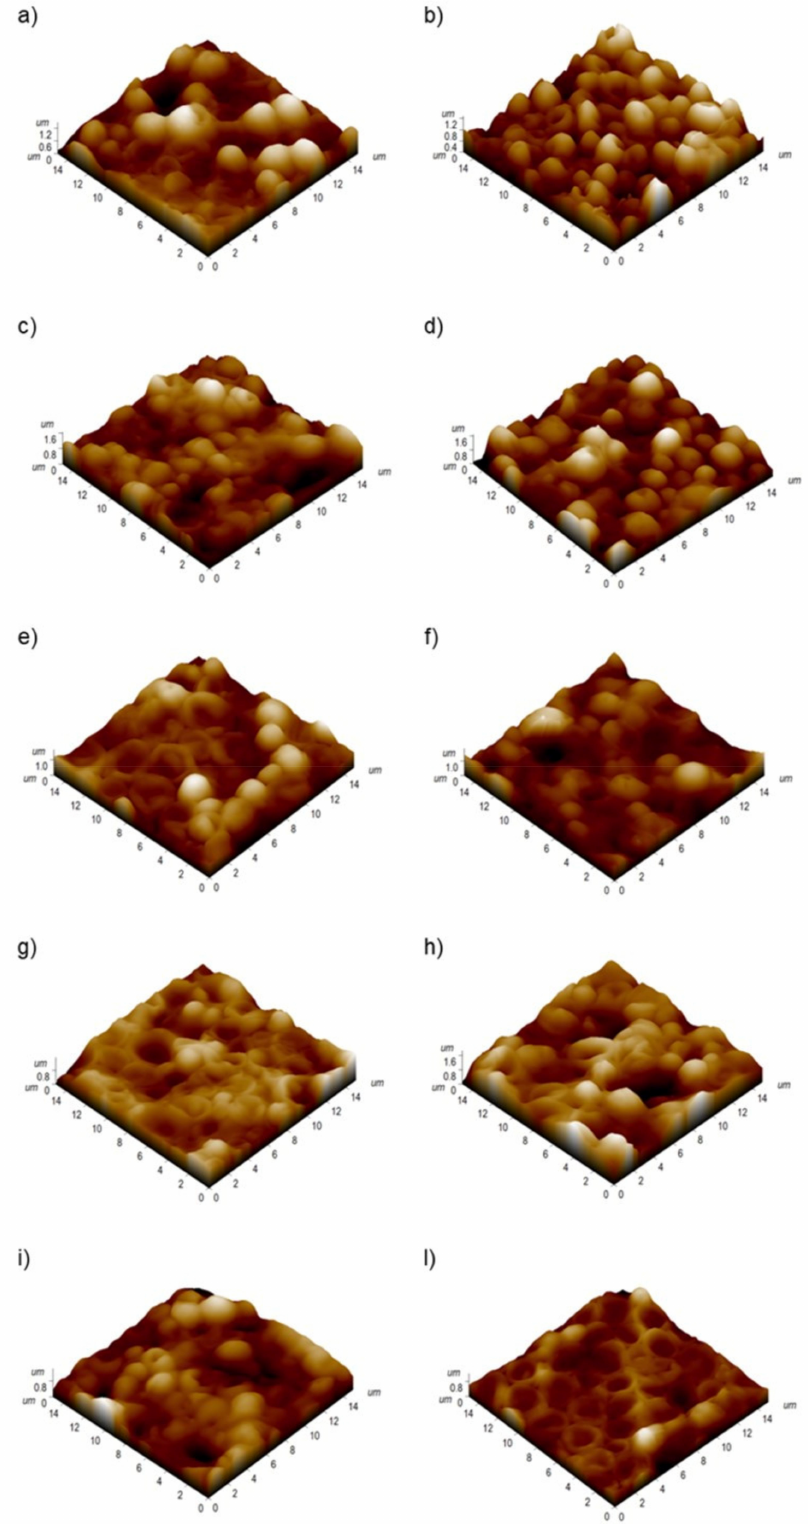
Figure 9. Three dimensional AFM topographical acquisitions, performed on PMMA ( a , b ), PMMA + TiO 2 NPs 1% ( c , d ), PMMA + TiO 2 NPs 3% ( e , f ), PMMA+ HNTs 1% ( g , h ), PMMA+ HNTs 3% ( i , l ) substrates after 24 h ( a , c , e , g , i ) and 48 h ( b , d , f , h , l ) of C. albicans